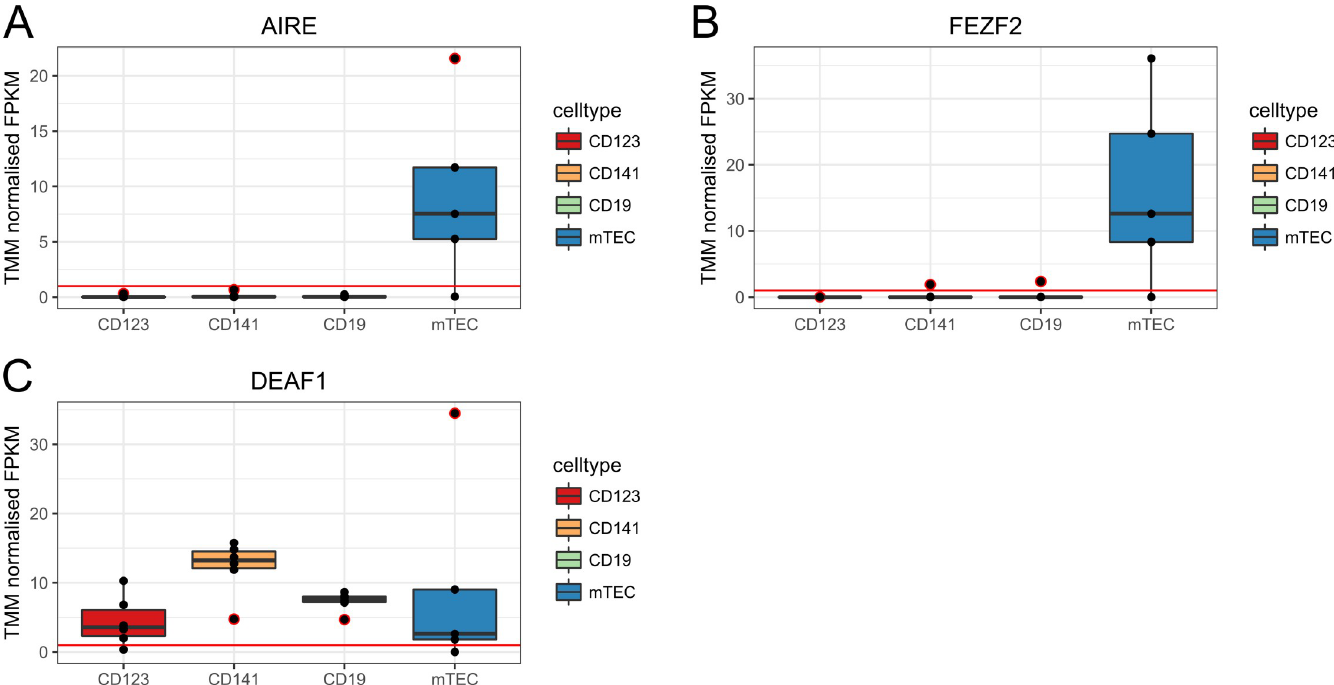
Fig 3. Expression levels of the three transcriptional regulators. (A) AIRE (B) FEZF2 and (C) DEAF1 . Boxplots represent the median and quartiles of the relative RNA expression levels as normalized FPKM. The X-axis shows the individual thymic APCs and the Y-axis shows the TMM normalized FPKM. An expression level minimum has been set at FPKM = 1 (red line). Black dots represent the individual biological replicates. Black dots encircled in red are outliers.